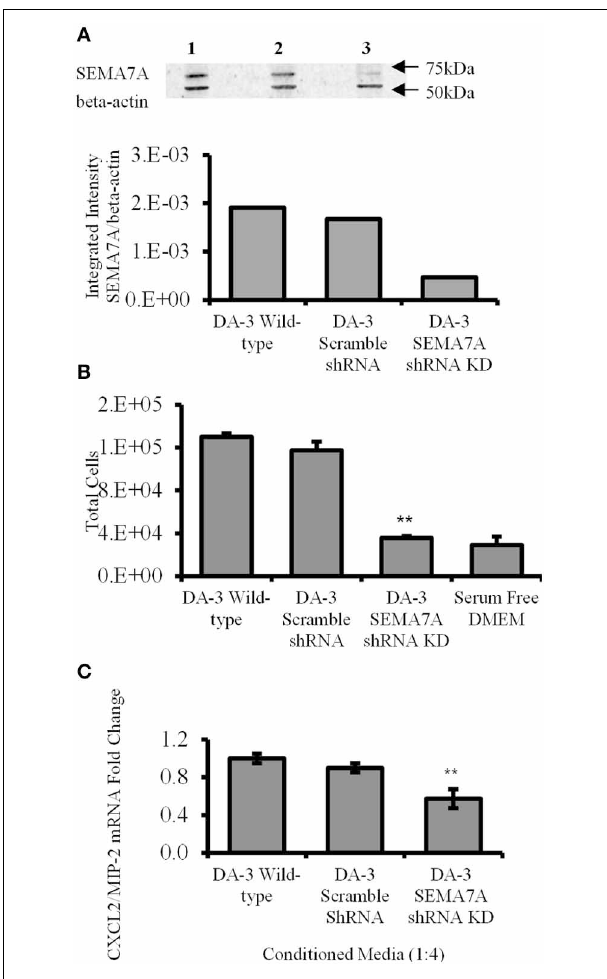
FIGURE 4 | Decreased tumor-derived SEMA7A results in reduced in vitro macrophage migration and CXCL2/MIP-2 production. (A) Effect of SEMA7A gene silencing on SEMA7A expression in DA-3 mammary tumor cells as determined by western blot analysis; (B) migration of Calcein AM labeled RAW 264.7 macrophages toward cell-free supernatants from either wild type DA-3 tumor cells, SEMA7A scramble shRNA DA-3 tumor cells, SEMA7A shRNA knockdown DA-3 cells or serum free media alone. (C) mRNA expression of CXCL2/MIP-2 on macrophages from normal mice in vitro treated with conditioned media from either wild type, SEMA7A scramble or SEMA7A knockdown DA-3 mammary tumor cells. In-vitro experiments are representative of three independent experiments. ∗∗ p ≤ 0 .